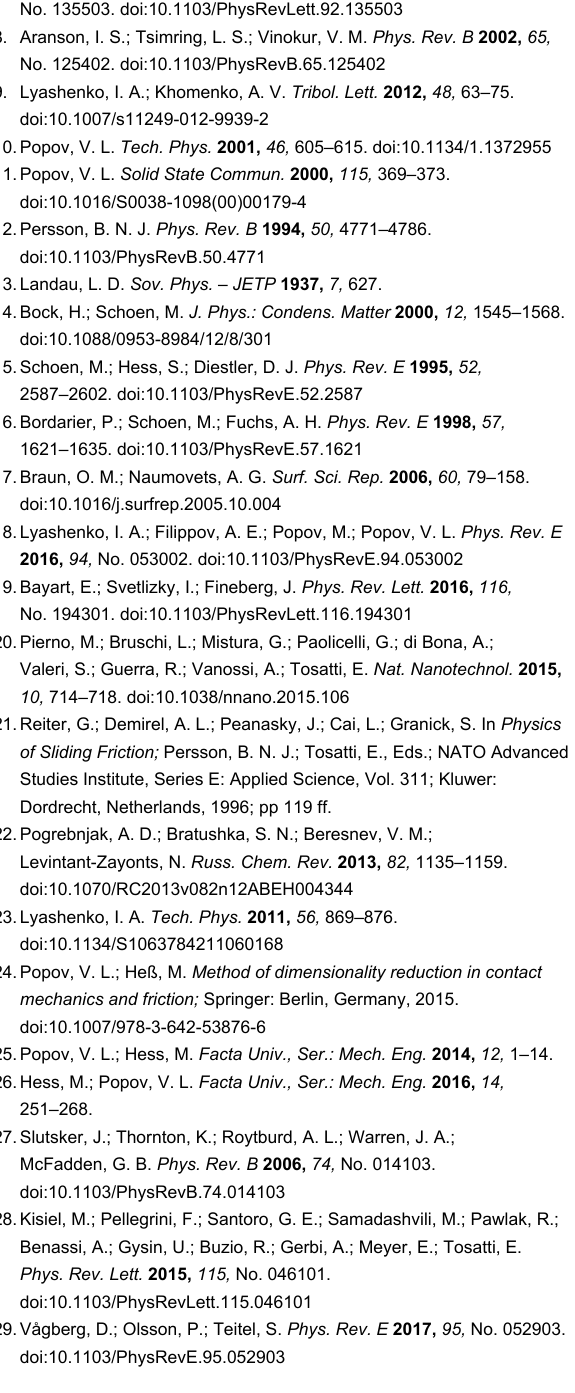
Figure 5. This situation confirms the assumption that the fre- quency of the phase transitions increases (as it is shown in Figure 2 and Figure 4) due to the increase in the strain